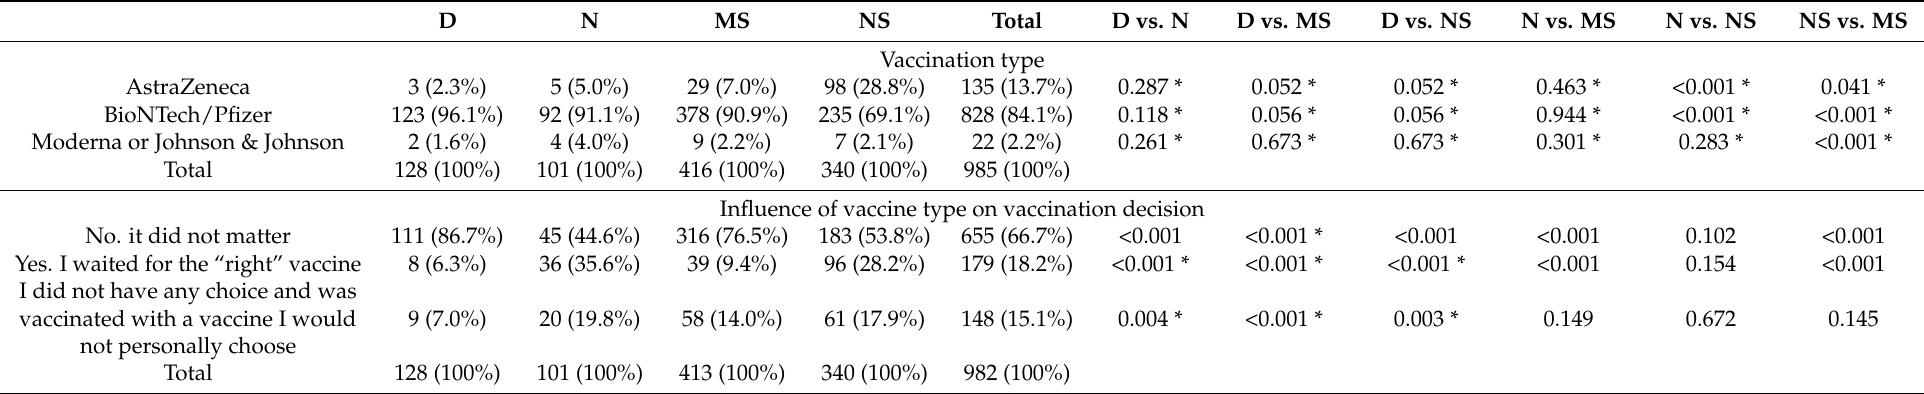
Table 4. The decision to vaccinate against COVID-19 and the type of vaccine (AstraZeneca, BioNTech/Pfizer, Moderna, Johnson & Johnson) in four groups of vaccinated healthcare